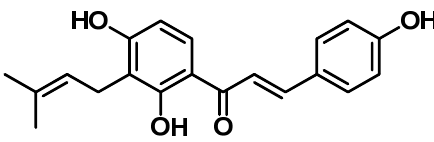
Figure 1. Structure of Isobavachalcone ( IBC ).